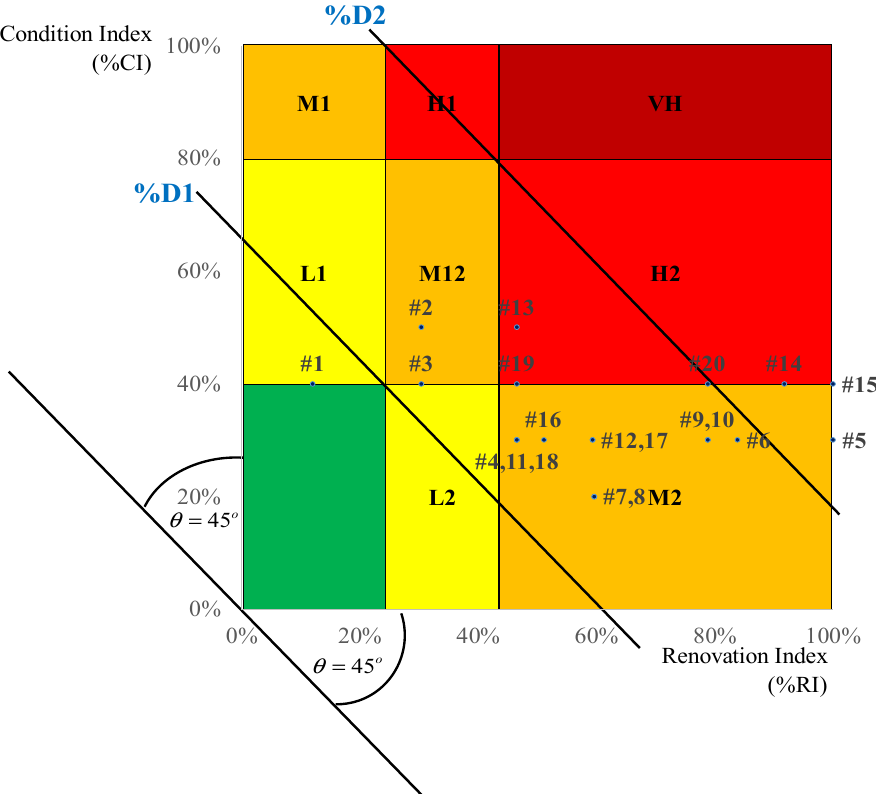
Figure 5. Failure probability evaluation of twenty 115 kV HVCBs using the risk matrix.